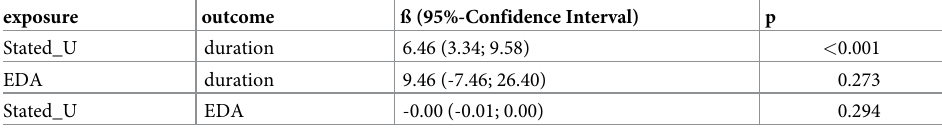
Table 3. Statistical analysis on the association between Stated_U and duration for each triplet annotation task (first row), between EDA and duration (second row) and between EDA and Stated_U (last row). The association between Stated_U and duration is